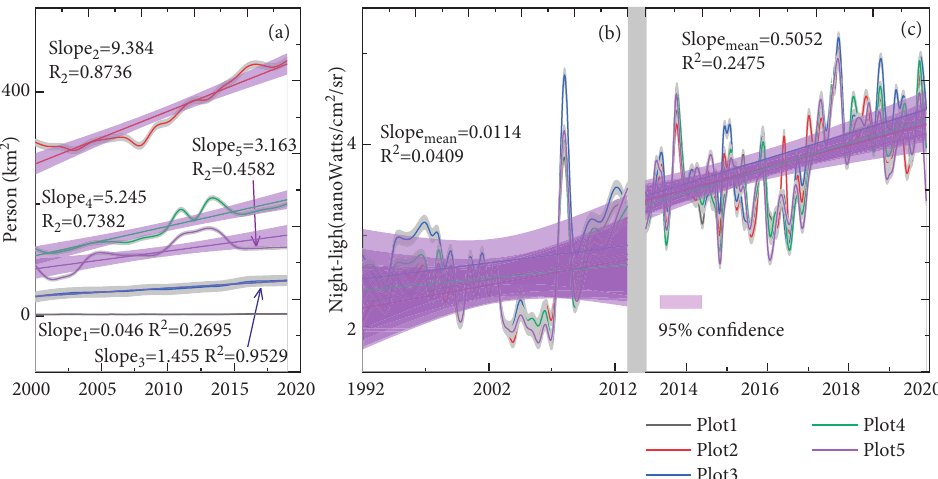
Figure 15: External disturbance changes trend of the swamp wetland on a plot scale. (a), (b), and (c) are the change trend of